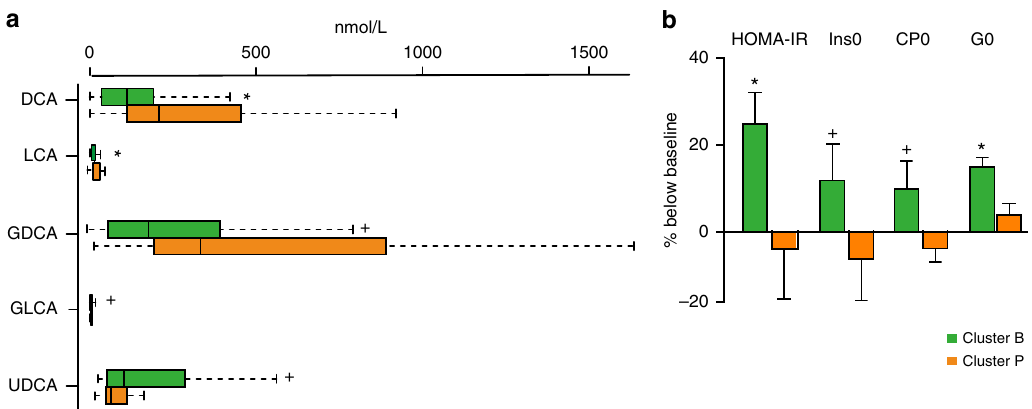
Fig. 5 Plasma bile acid composition and therapeutic responses to Acarbose treatment differ in patients with a different baseline microbiota composition. a Plasma composition of bile acids in patients belonging to baseline enterotype-like clusters driven by Bacteroides (Cluster B) or Prevotella (Cluster P). Plasma levels of DCA, LCA, GDCA, GLCA and UDCA differed signi fi cantly between Cluster B and Cluster P at the baseline; plotted boxes are interquartile ranges. Dark lines in the boxes indicate medians, the lowest and highest values within 1.5 times IQR from the fi rst and third quartiles, Wilcoxon rank-sum test, * P < 0.01, + P < 0.05. DCA deoxycholic acid, LCA lithocholic acid, GDCA glycodeoxycholic acid, GLCA glycolithocholic acid, UDCA ursodeoxycholic acid. b Percentage changes over baseline levels of fasting blood glucose (G0), insulin (Ins0), C peptide (CP0) and HOMA-IR differed signi fi cantly between Cluster B and Cluster P after Acarbose treatment; paired Wilcoxon rank-sum test, * P < 0.01, + P < 0.05. Cluster B, n = 36, Cluster P, n = 15 in Acarbose arm, bar plot is shown as mean ±